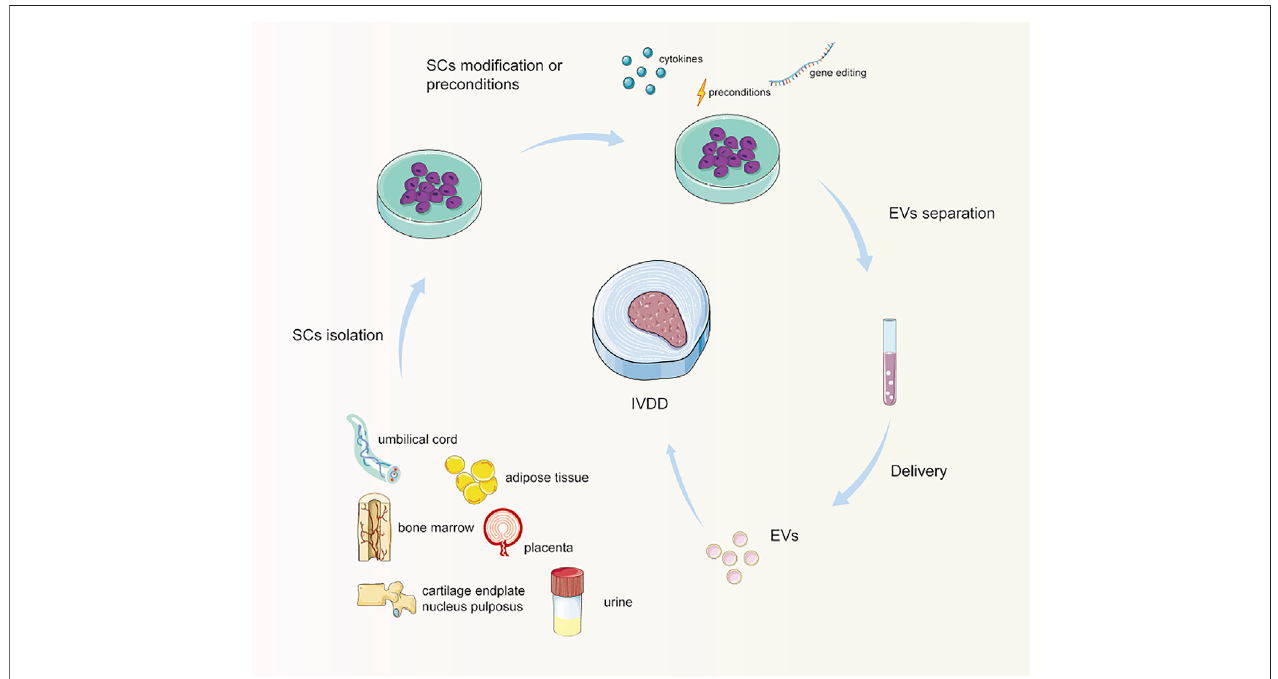
FIGURE 2 | Schematic diagram of stem cell-derived extracellular vesicle separation and delivery. Stem cells are isolated and cultured from different origins. Optionally, stem cells are preconditioned or modi fi ed, especially genetically engineered. Then, EVs are separated and enriched, and delivered to the IVD for treatment. Note: SCs, stem cells; EVs, extracellular vesicles; IVD, intervertebral disc.